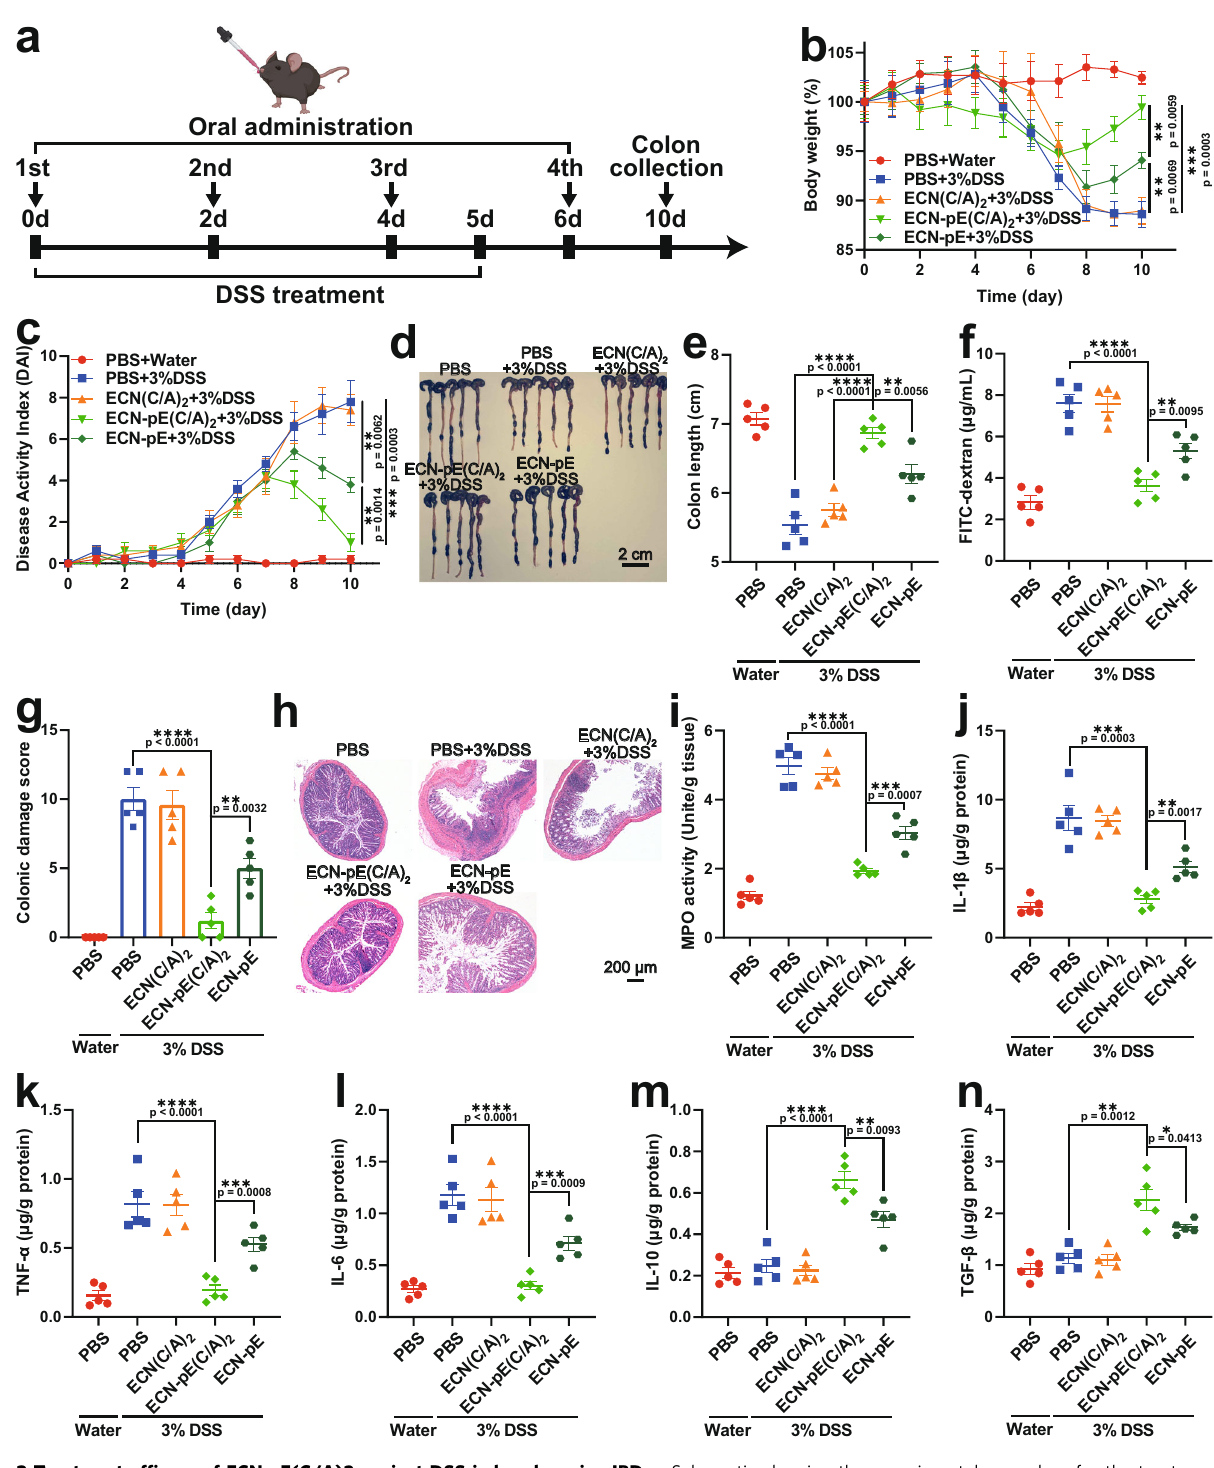
Fig. 3 Treatment ef fi cacy of ECN-pE(C/A)2 against DSS-induced murine IBD. a Schematic showing the experimental procedure for the treatment of DSS-induced IBD mice. C57BL/6 mice were given drinking water containing 3% DSS from day 0 to day 5. Meanwhile, the mice were fed PBS, ECN(C/A) 2, ECN-pE(C/A) 2 or ECN-pE (1 × 10 8 CFU) on days 0, 2, 4, and 6 by gavage. b The body weight of the mice with different treatments. c The DAI of mice during the treatment. d Photographs and ( e ) corresponding quanti fi ed lengths of colons harvested from mice 10 days after different treatments. Scale bar: 2 cm. f The intestinal integrity function of mice was assessed by FITC-dextran assay after different treatments. g The colonic damage scores of mice after different treatments. h Representative images of H&E staining of colon tissue harvested on day 10 after different treatments from fi ve